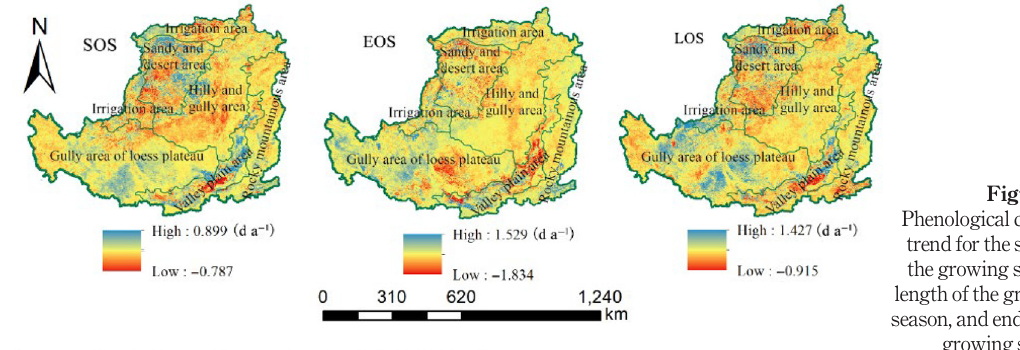
Figure 4. Phenological